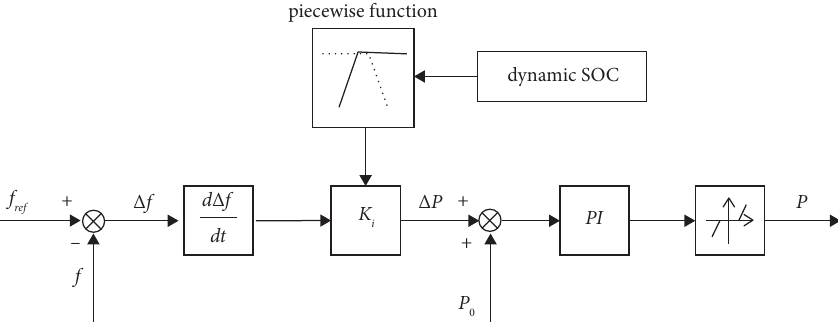
Figure 2: Improved virtual inertial control based on piecewise